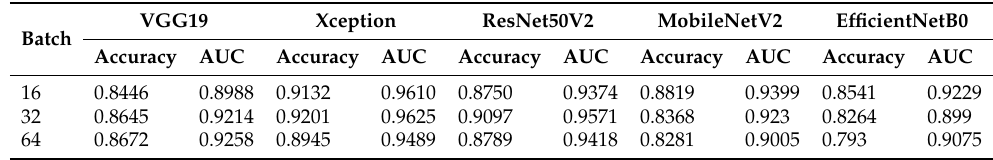
Table 6. Accuracy and AUC values for different batch